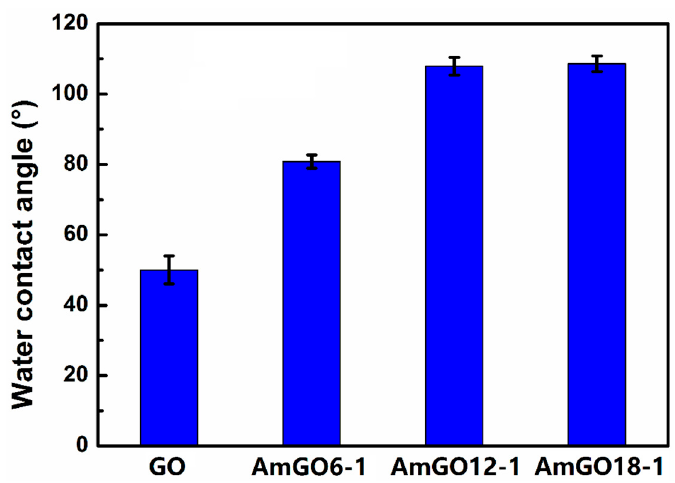
Figure 3. Water contact angles of GO, AmGO6-1, AmGO12-1 and AmGO18-1.